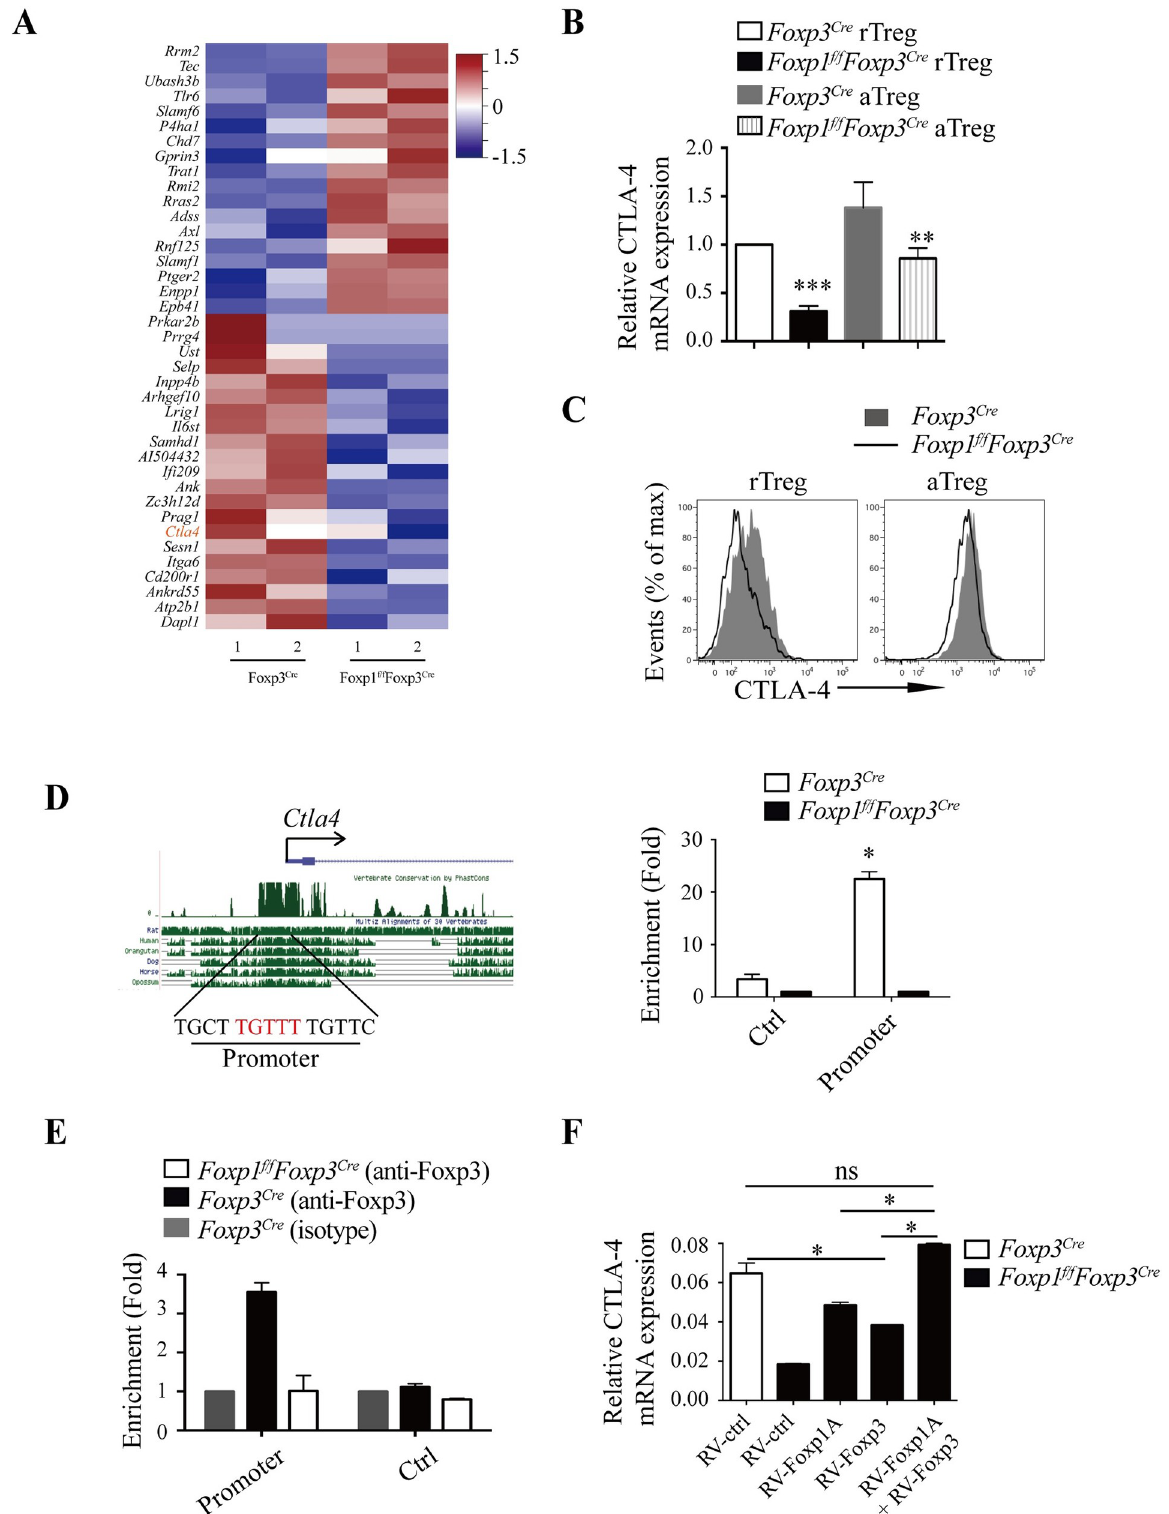
Fig 8. Foxp1 and Foxp3 coordinate the regulation of CTLA-4 expression in Treg cells. (A) Heatmap of the representative common target genes of Foxp1 and Foxp3 in rTreg cells. (B) The relative mRNA levels of CTLA-4 in purified rTreg and aTreg cells from Foxp3 Cre and Foxp1